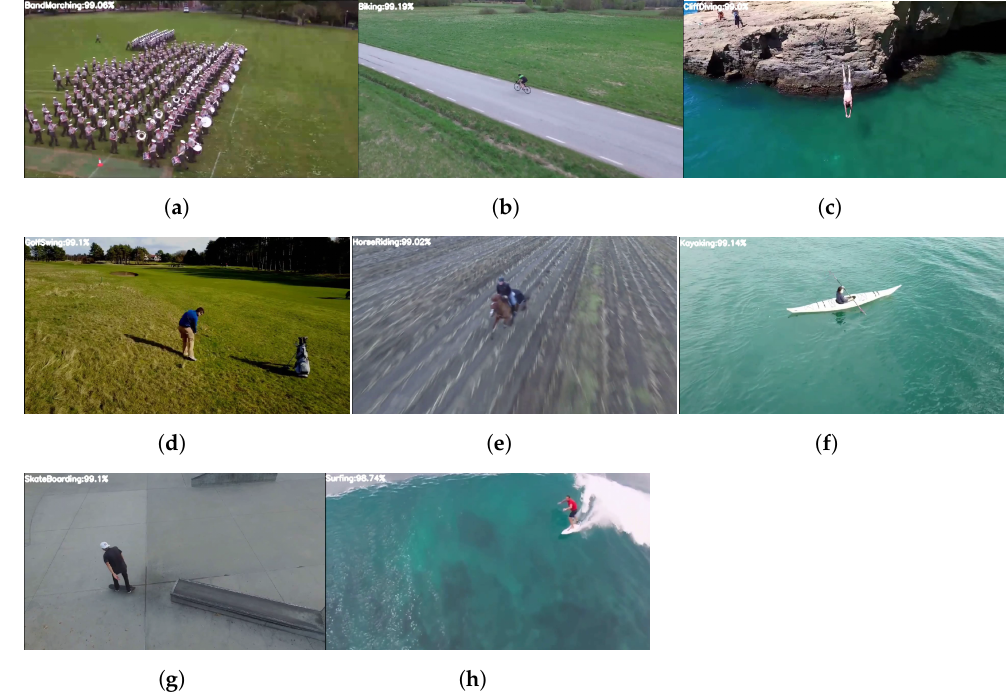
Figure 17. Human activities with the percentage of accuracies. ( a ) BandMarching. ( b ) Biking. ( c ) CliffDiving. ( d ) GolfSwing. ( e ) HorseRiding. ( f ) Kayaking. ( g ) SkateBoarding. ( h ) Surfing.